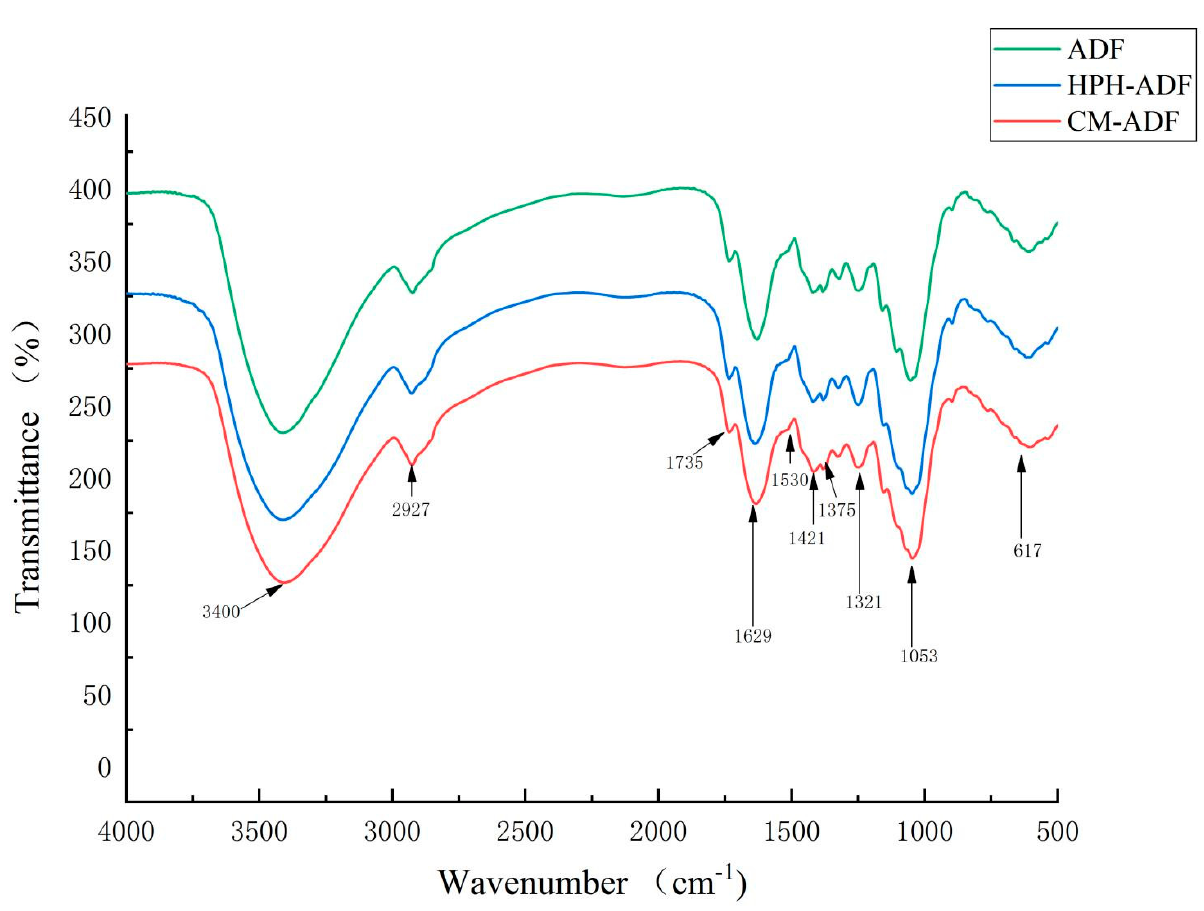
Figure 3. FTIR spectra of the ADF, HPH-ADF and CM-ADF groups.